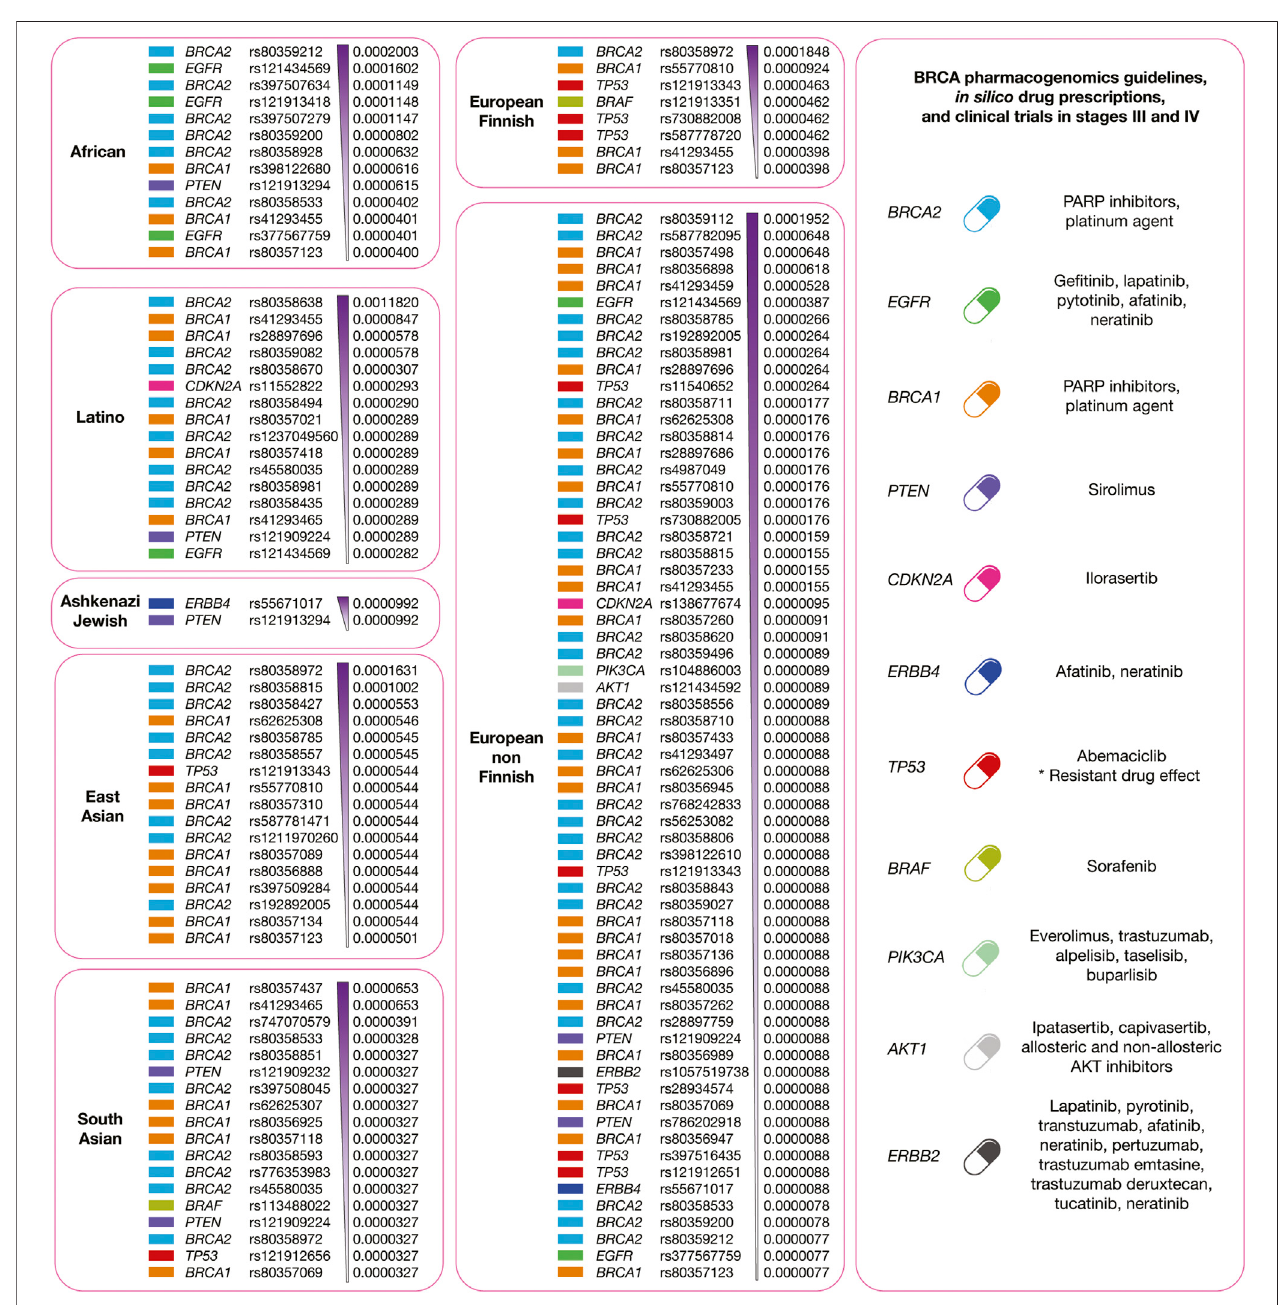
FIGURE 10 | Precision medicine of BRCA per human population. On the left, druggable BRCA driver proteins carrying known oncogenic variants with the highest allele frequencies and the highest deleteriousness scores per human population. On the right, integration of pharmacogenomics guidelines, drug prescription, and clinical trials according to druggable BRCA driver